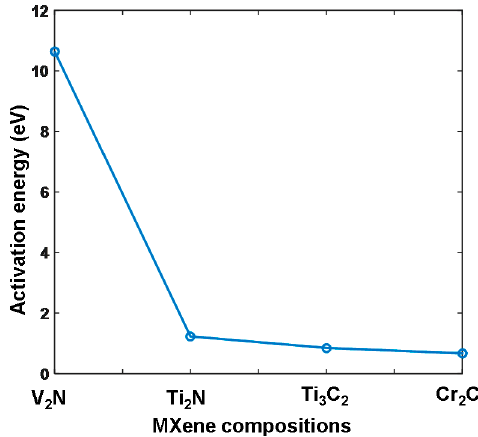
Figure 5. Calculated activation energies as a function of the designed stacks using different MXene compositions.